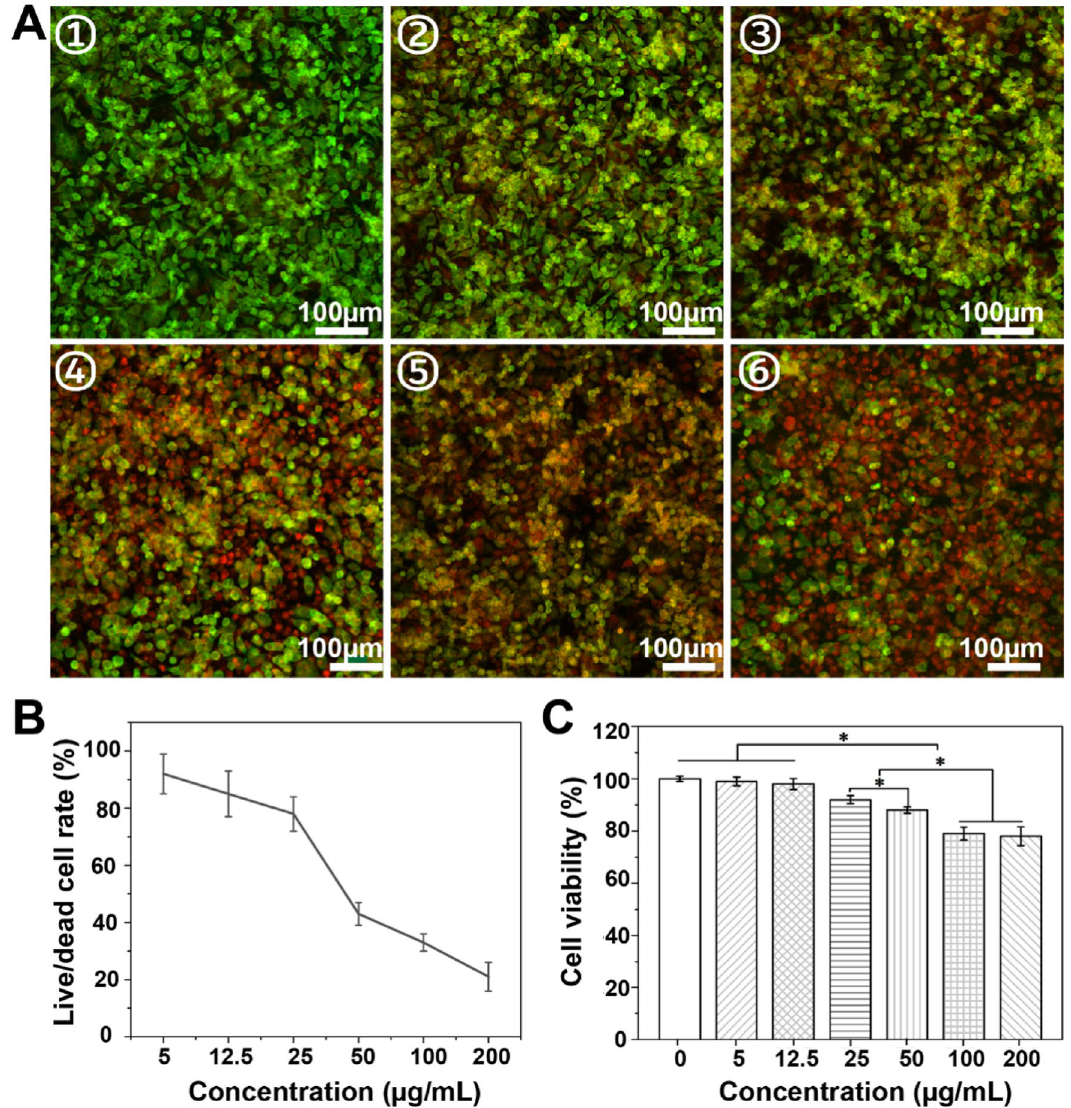
Figure 5. ( A ) Representative images of dead/live staining and ( B ) semi-quantification of the dead/live rate analysis with the ImageJ software. Live cells (green) were stained with calcein-AM, and dead cells (red) were stained with PI. Subfigures ① – ⑥ show 5, 12.5, 25, 50, 100, and 200 μg/mL of tri-bead/azo/DOX microrobots with the NIR irradiation (2 W/cm 2 for 5 min). The scale bar is 100 μm. ( C ) H1299 cells viability test by CCK-8 incubated with different concentrations of tri-bead/azo microrobots without NIR irradiation for 24 h. Asterisks indicate significant differences, *p < 0.05, n =